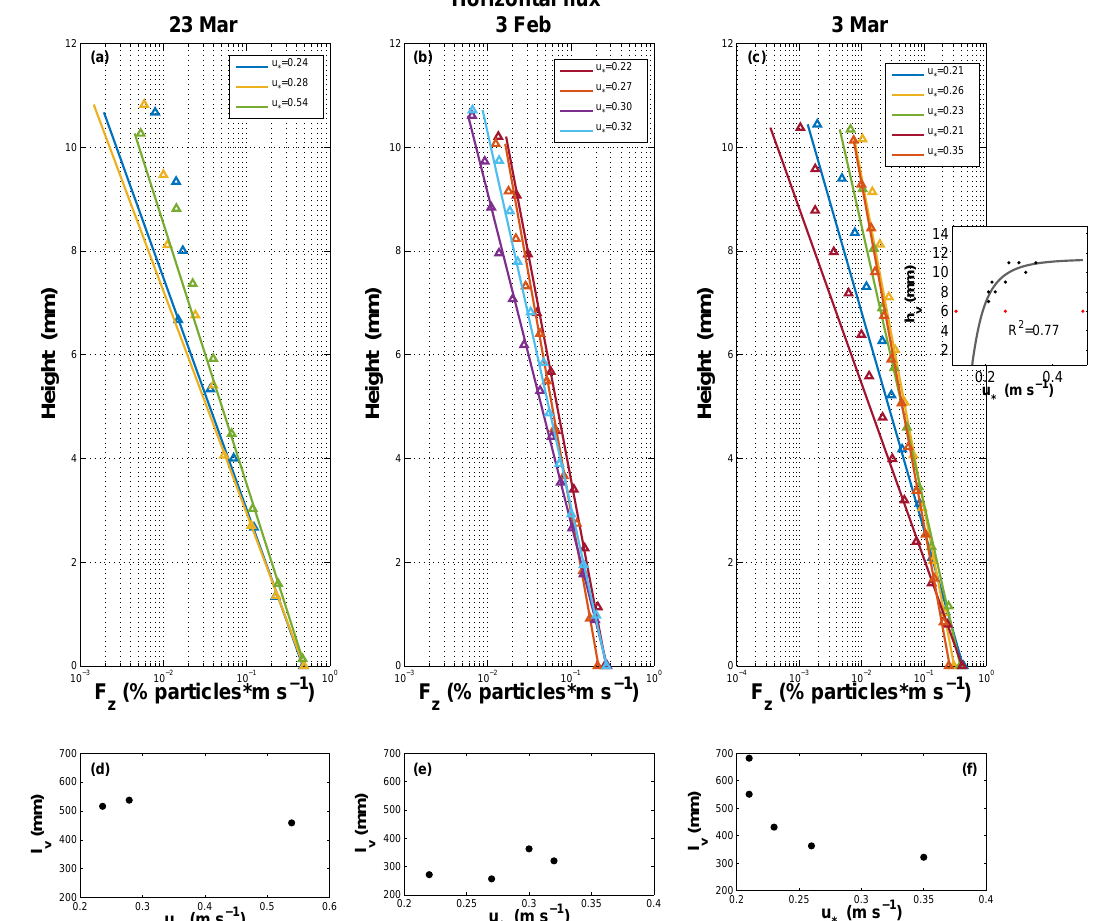
Figure 7. Plots (a–c) are mean horizontal flux measurements ( F z ) and best-fit exponential decay. Plots (d–f) are friction velocity vs. decay length for each night. Friction velocity vs. h v (height below which 75% number flux occurred) for all nights with power law curve fitting is seen in the right inset. Values of h v from 23 March 2015 are marked in